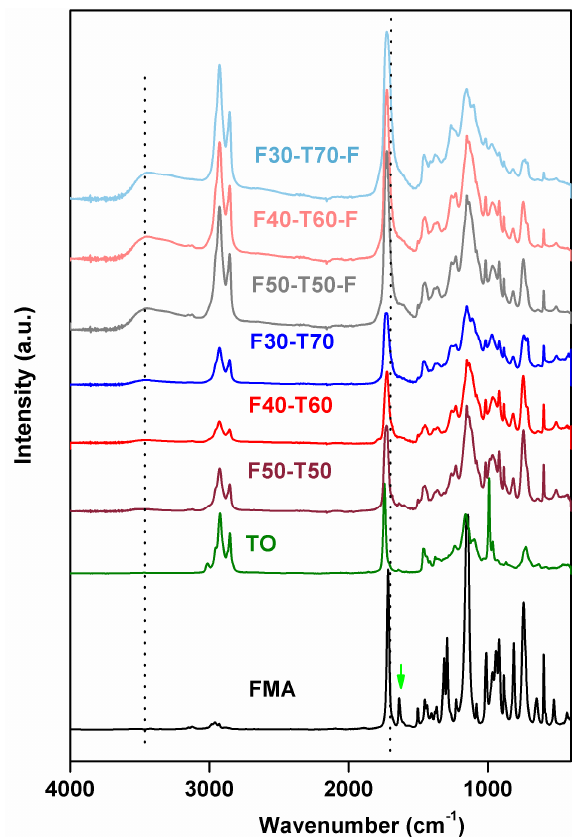
Figure 3. FTIR (Fourier-transform infrared) plots of powder and film samples (dotted line indicates peaks at 3469 and 1716 cm − 1 ; green arrow indicates peak at 1634 cm − 1 ).